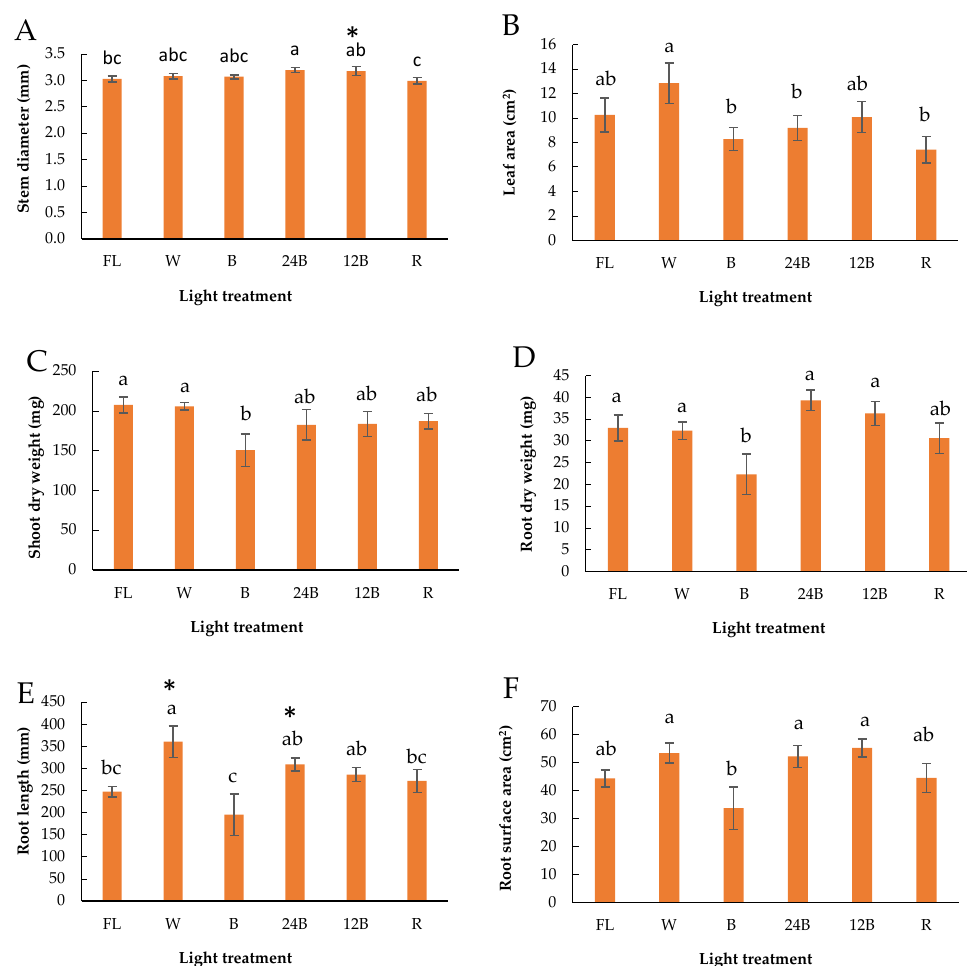
Figure 3. ( A ) Stem diameter, ( B ) leaf area, ( C ) shoot dry weight, ( D ) root dry weight, ( E ) root length and ( F ) root surface area of 6 grafted tomato seedlings per light treatment during healing, 14 days after acclimatization process plus seven days after transplantation. Bars (±SE) followed by different letters are significantly different ( p ≤ 0.05) according to the LSD method. Bars (±SE) followed by asterisks indicate significant differences between the LED treatments and the control (FL) at p ≤ 0.05 according to t -test. FL: fluorescent lamps; W: white; B: blue; 24B: 24% blue; 12B: 12% blue; R: red.